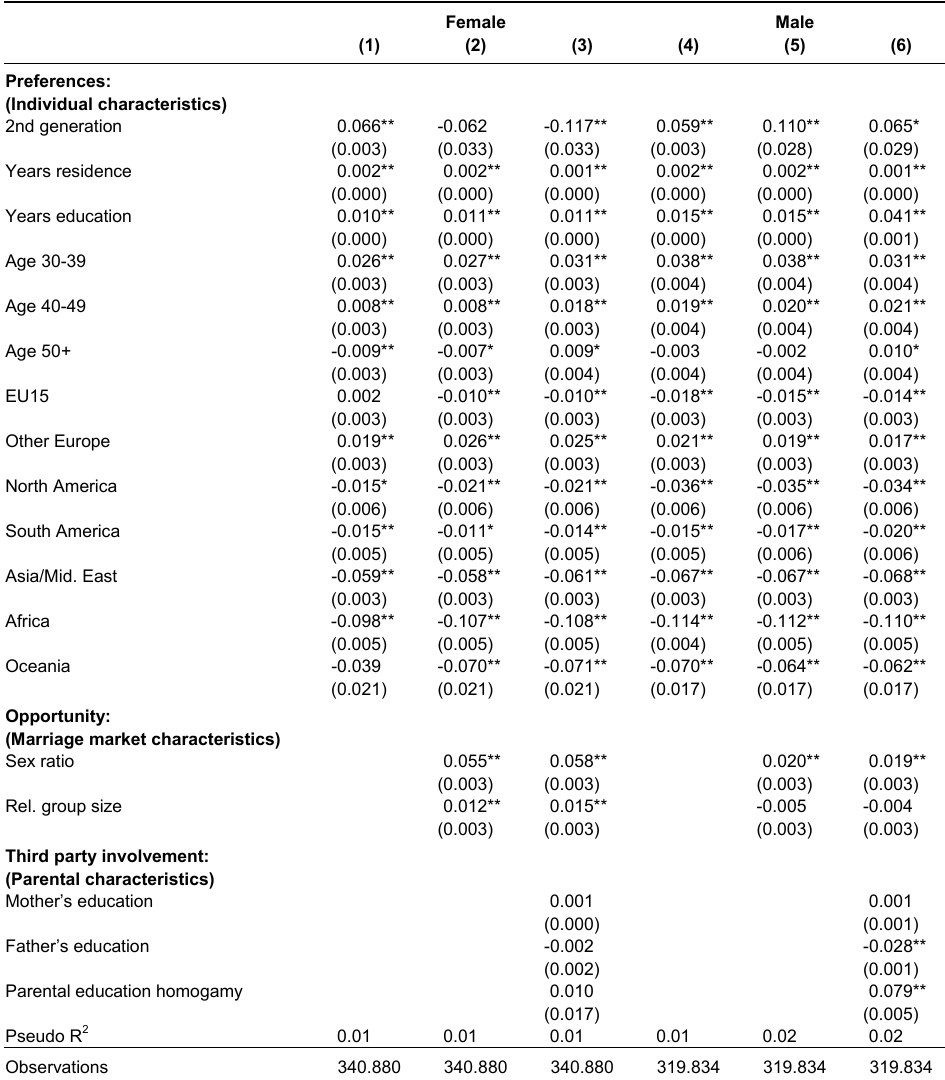
Table 4: The probability of educational